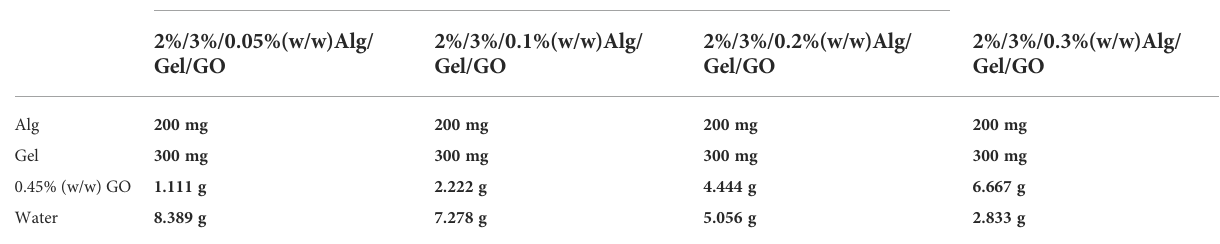
TABLE 1 Formulation of Alg/Gel/GO ink with different GO